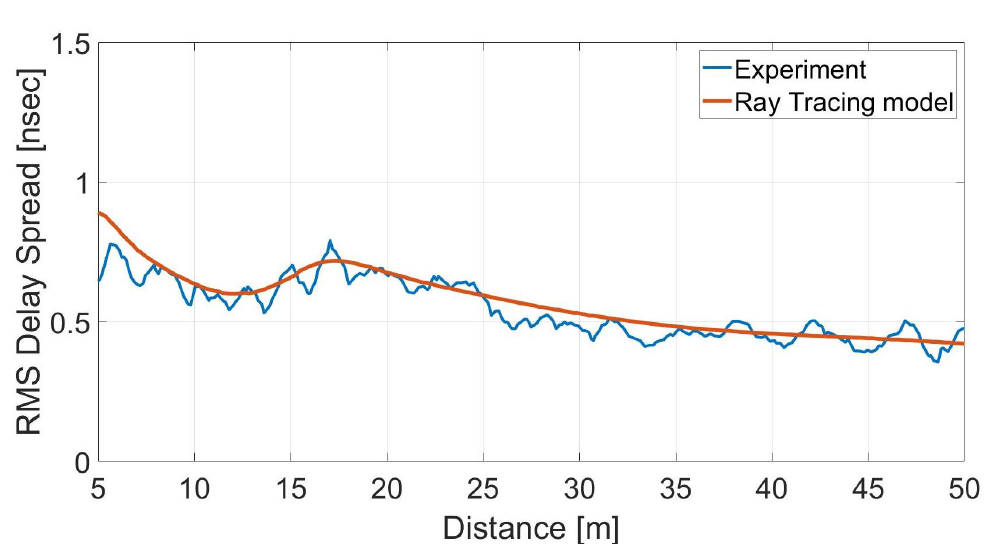
Figure 10. RMS delay spread comparison between the experiment and simulation.